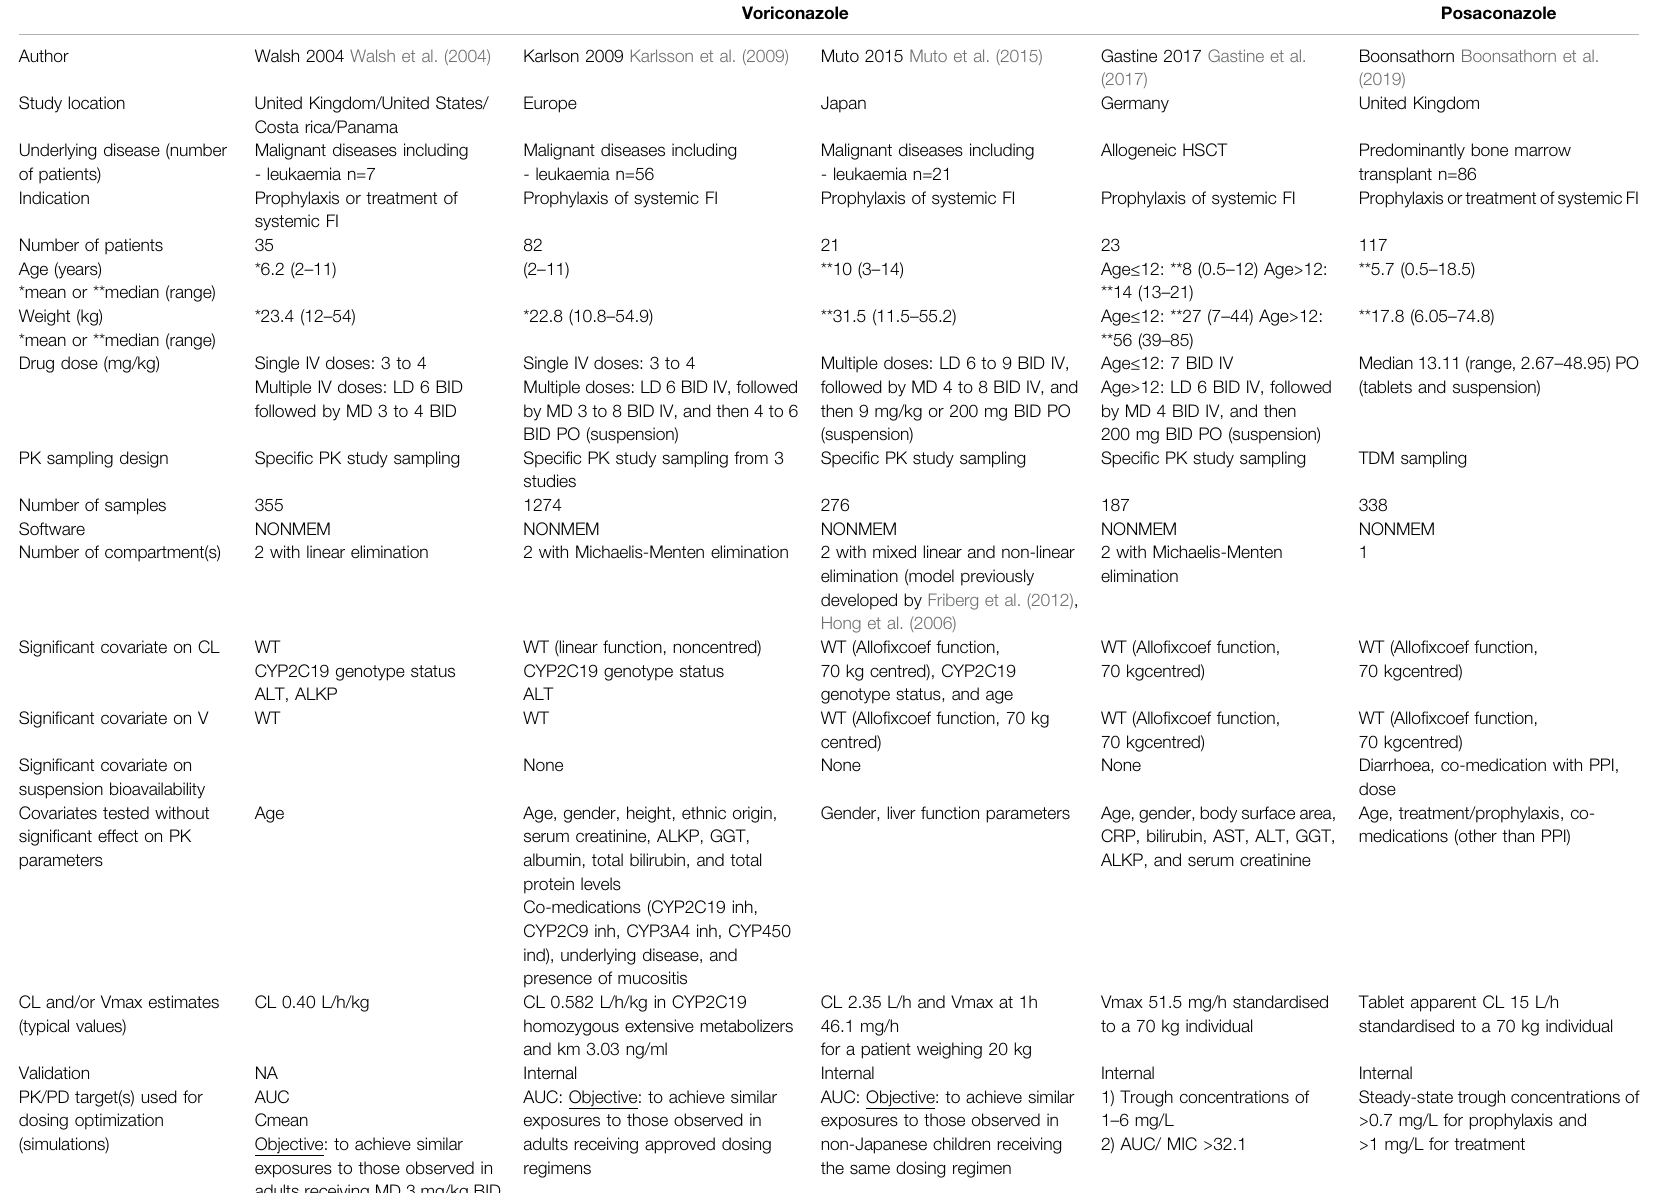
TABLE 3 | Population pharmacokinetic studies of the antifungals Voriconazole and Posaconazole in paediatric onco-hematological